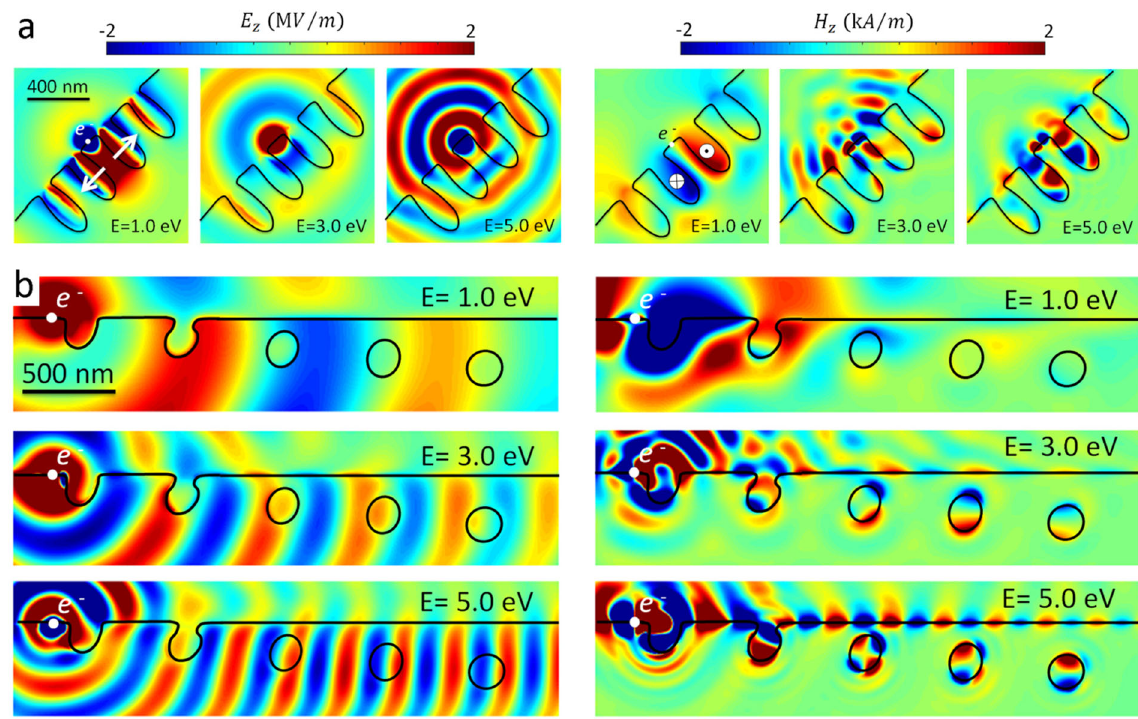
Fig. 6 FDTD simulations for hyperbolic polaritons interacting with engineered defects. a , b FDTD simulations for the investigated structures being excited by fast electrons at the positions marked in white color. The color-coded images show the z -component of the electric and magnetic fi eld strength for different excitation energies. The images depict temporal snapshots. Supplementary Movies 1 – 4 are available